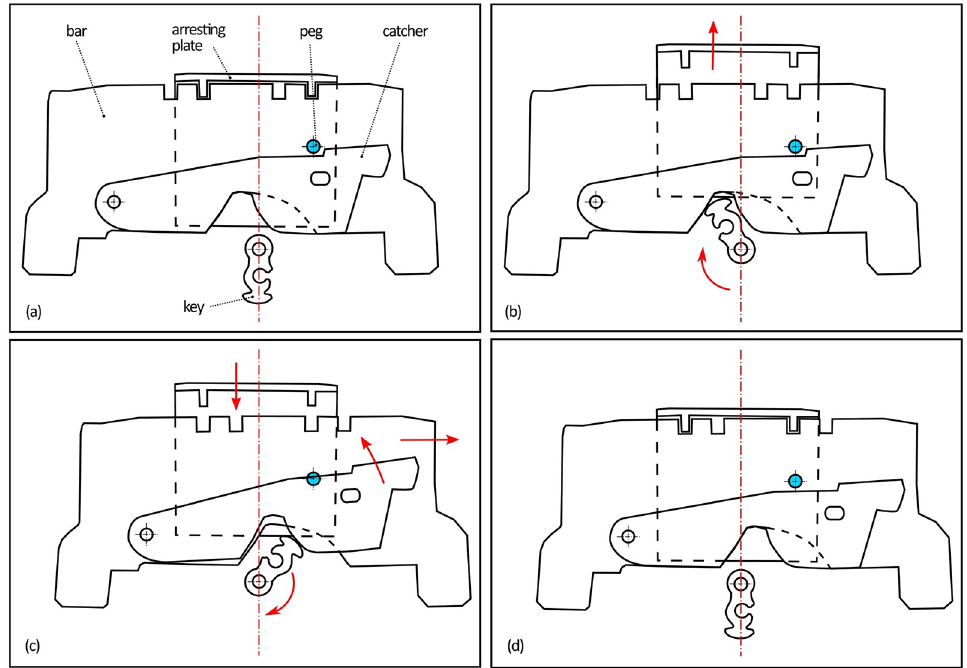
Fig 6. The first mechanism motion scheme from the locked position (a) to the unlocked position (d) marked by the arrows, demonstrating the malfunction of the third mechanism; the trajectory of the hole cannot reach the position of the peg (marked